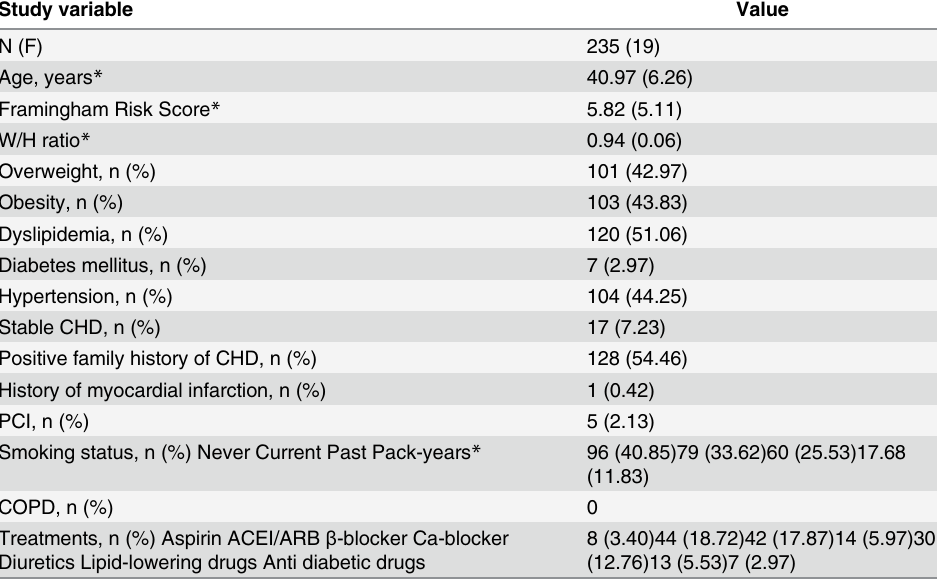
Table 1. Clinical characteristics of the study